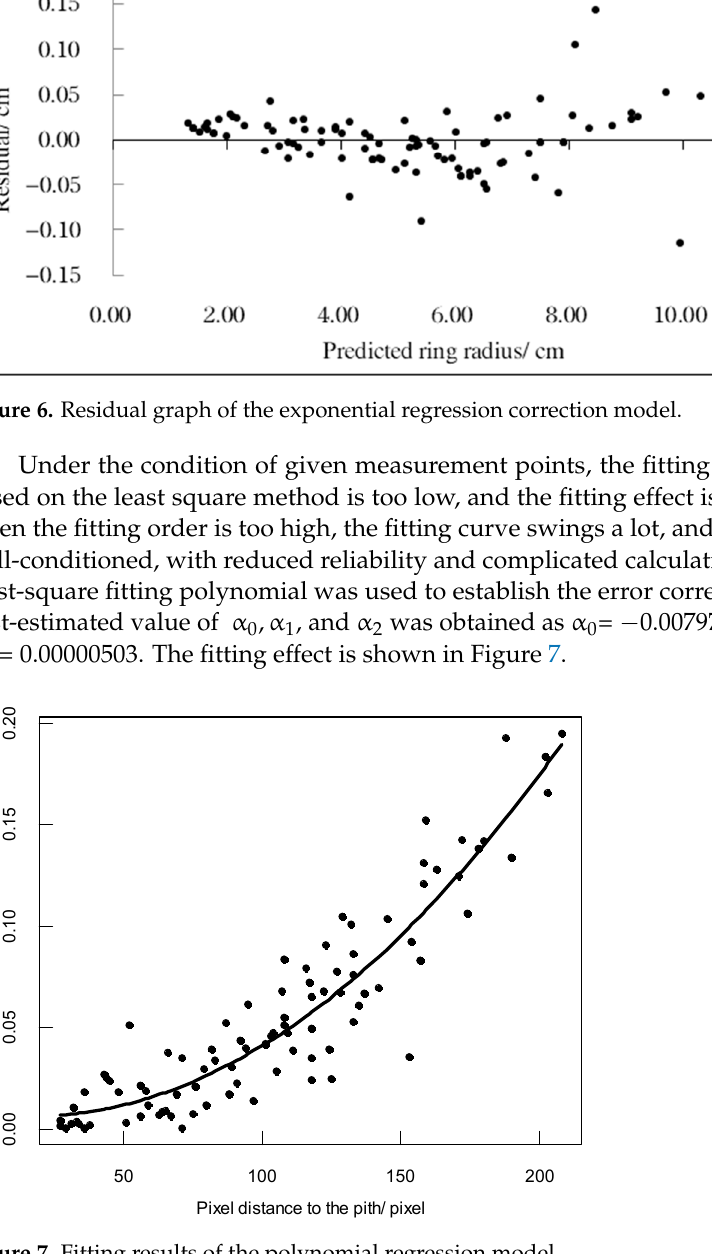
Figure 7. Fitting results of the polynomial regression model.